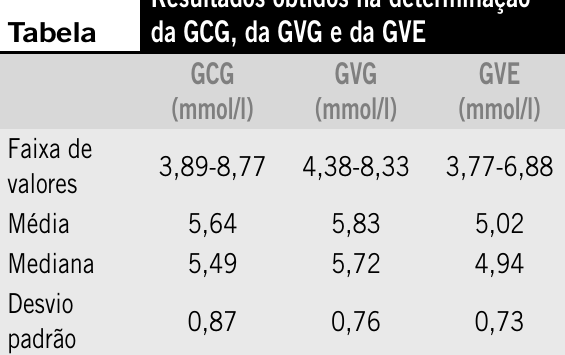
das doenças cardiovasculares (DCVs) encontra-se o DM,